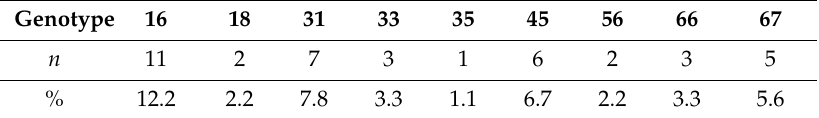
Table 1. Types of detected high-risk HPV.